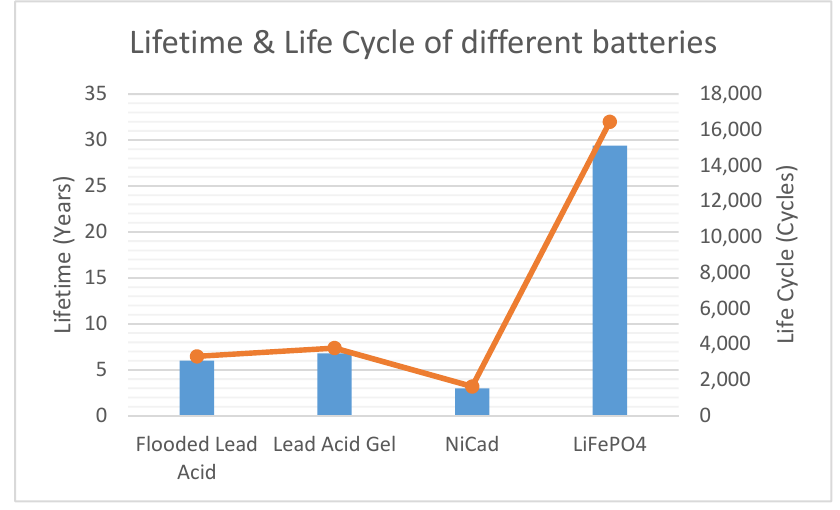
Figure 3. Comparison between lifetime and life cycle of different batteries.